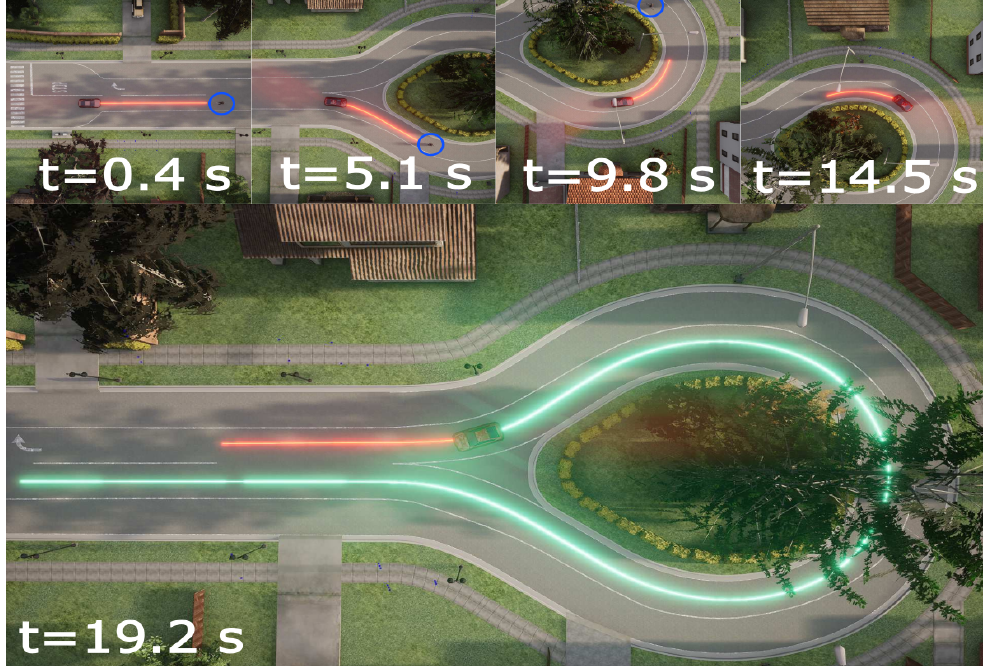
Figure 7. Generated trajectory at different times. The local path planning is displayed in red, whereas the effective path followed by the ego-vehicle is displayed in green. The preceding vehicle (bicyclist) is marked by a blue circle.